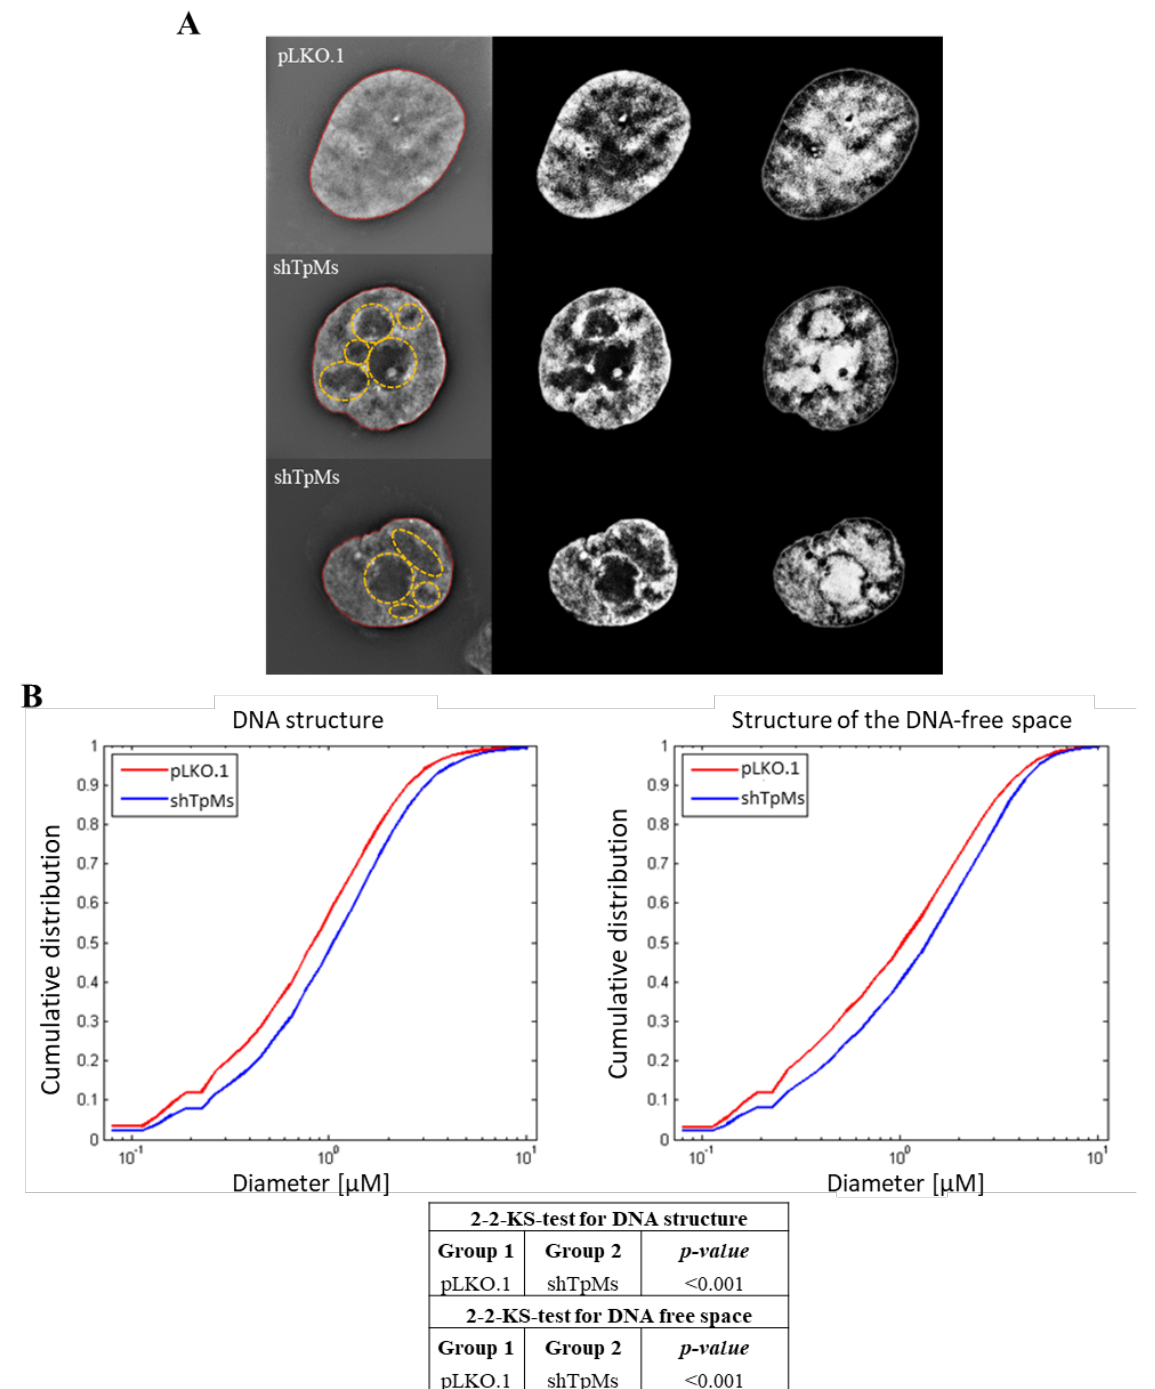
Figure 5. TpMs − depleted cells present different DNA structure and content in the DNA-free space. ( A ) Representative images from DAPI-stained nuclei of TpMs-depleted HCT116 cells (middle and bottom rows in the panel) and pLKO.1 control cells (top row). The scale bars are 5 μm in each image. Left panels: reconstructed 3D − SIM images; middle panels: light granulometry images; right panels: dark granulometry images. Images acquired with 63× Oil immersion objective. ( B ) Comparisons of cumulative size distribution of the DNA structure and DNA-free space between the two groups (pLKO.1 and shTpMs). All these size distributions are measured with a granulometry 2 − 2 − KS-test (Two-Sample Kolmogorov-Smirnov Test) , p -value < 0.001.